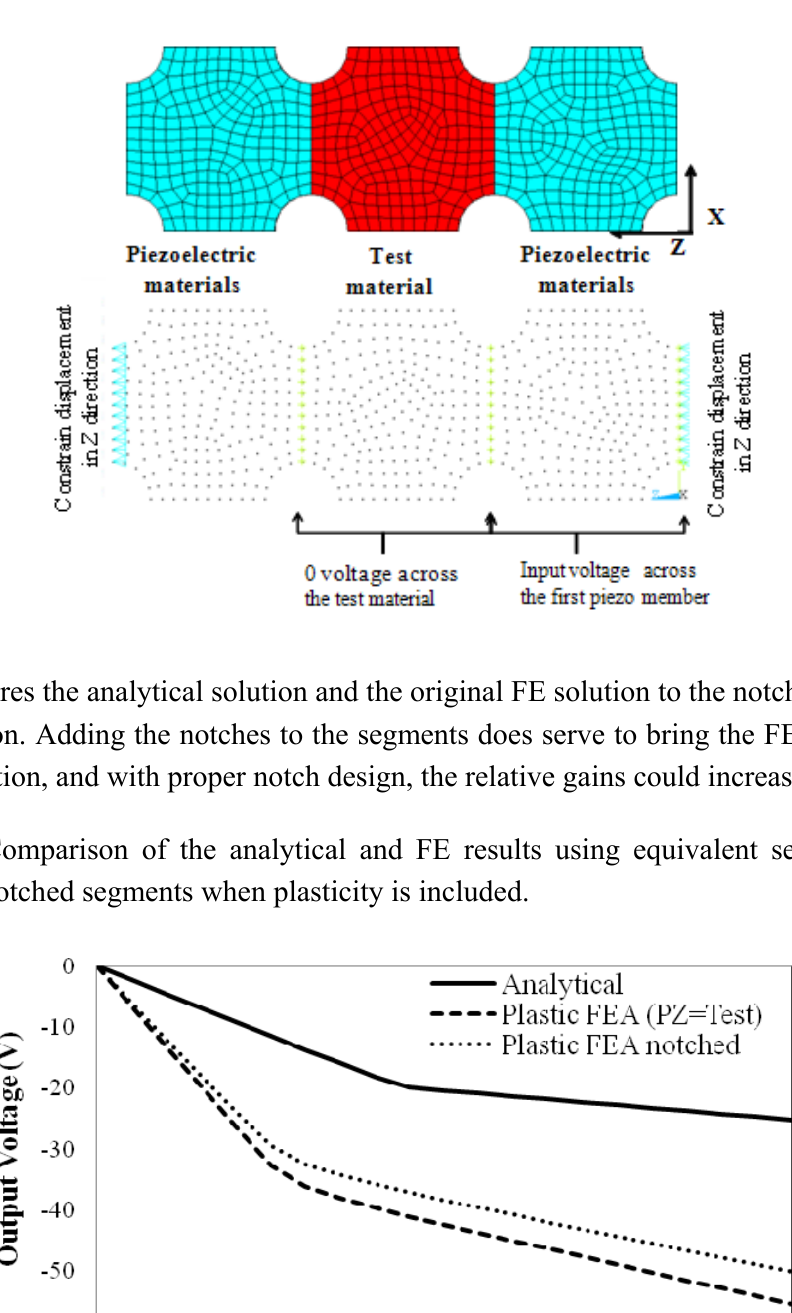
Figure 8. Finite element model of the strain sensing system where the segments are notched, with loads and constraints shown.